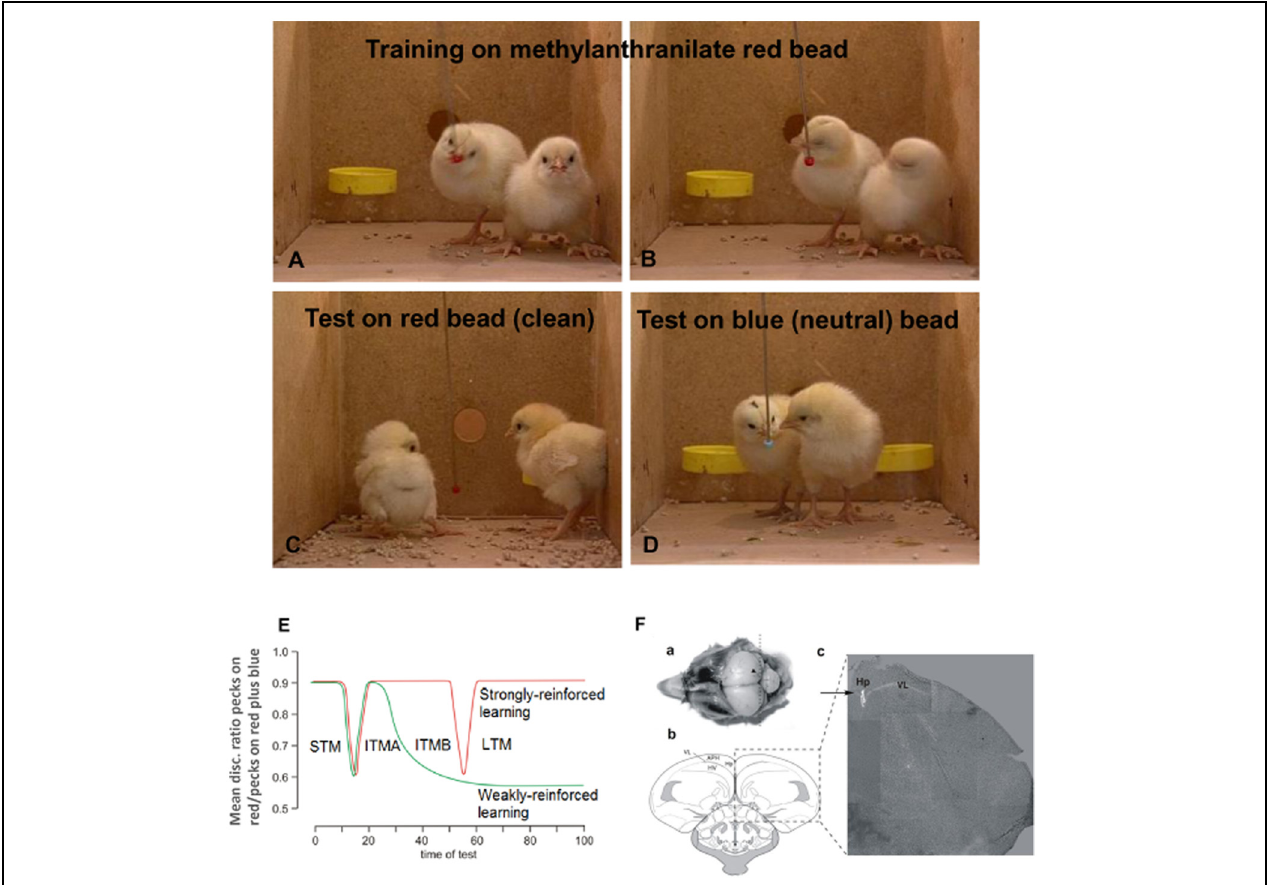
FIGURE 1 | Memory model established from single trial learning in day-old chicks. Prior to training chicks are presented once with clean red and blue beads to ensure they will peck at beads of both colors. For training they are presented for 10 sec with a red bead lightly coated in methyl anthranilate (A) . They peck at this once or twice before registering the bitter taste and turning away in disgust (B) . On test they are then presented with clean red (C) and blue (D) beads, each for 10 s and the number of pecks on each counted using an electronic counter and converted by computer to discrimination ratios (DRs). Perfect learning equals a DR of 1, and complete forgetting or inhibition of learning a DR of 0.5. Normally the DR after unimpaired learning is ∼ 0.9. The chicks are kept in pairs and 8–10 pairs are included in the group used in each experiment, which allows reliable determination of significance. Each data point on subsequent graphs represents one group. (E) Memory stages following strongly reinforced (red line) after exposure to undiluted aversant and weakly reinforced training (green line) after exposure to diluted aversant. The loss of labile, weakly reinforced memory coincides with the transition between two phases of intermediate memory (ITM A and B) 30 min post-training. Drugs are used to inhibit strongly reinforced learning or rescue weakly reinforced learning, as indicated by memory retained 120 min after training. (F) Illustration of injection for hippocampal administration of drugs. (a) Image of head with scull removed and injection site indicated by arrowhead. Dotted line indicates coronal section presented in panels (b) and (c). see Gibbs et al., 2008a for details. (1F from Gibbs et al.,